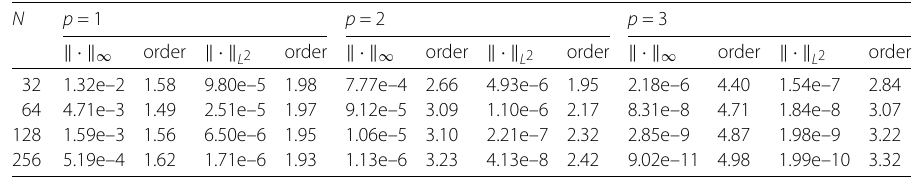
Table 1 Shishkin mesh, τ N = min { 0.5, (cid:2) (2 p + 1)ln( N + 1) } , (cid:2) = 10 –6